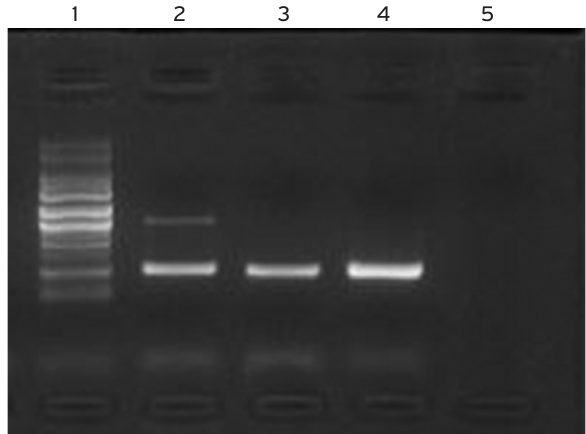
Figura1. Eletroforese em gel de agarose a 2% demonstrando o produto amplificado da reação em cadeia da polimerase, utilizando primers especificos para Brucella spp. com bandas de 223 bp. Coluna 1: marcador com peso molecular de 100